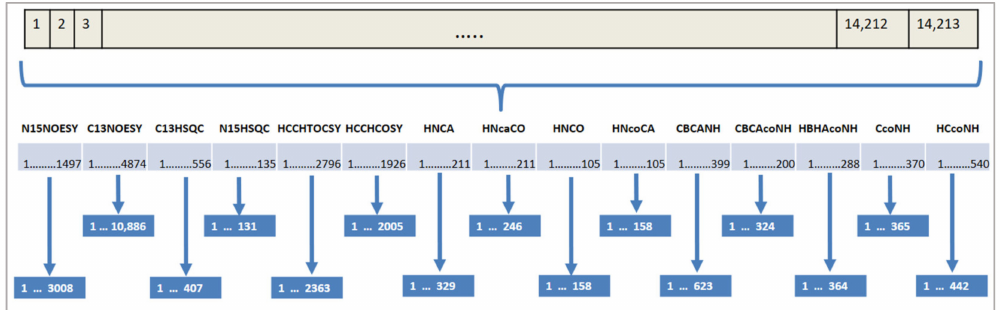
Figure 3. Chemical shift assignment representation for fifteen